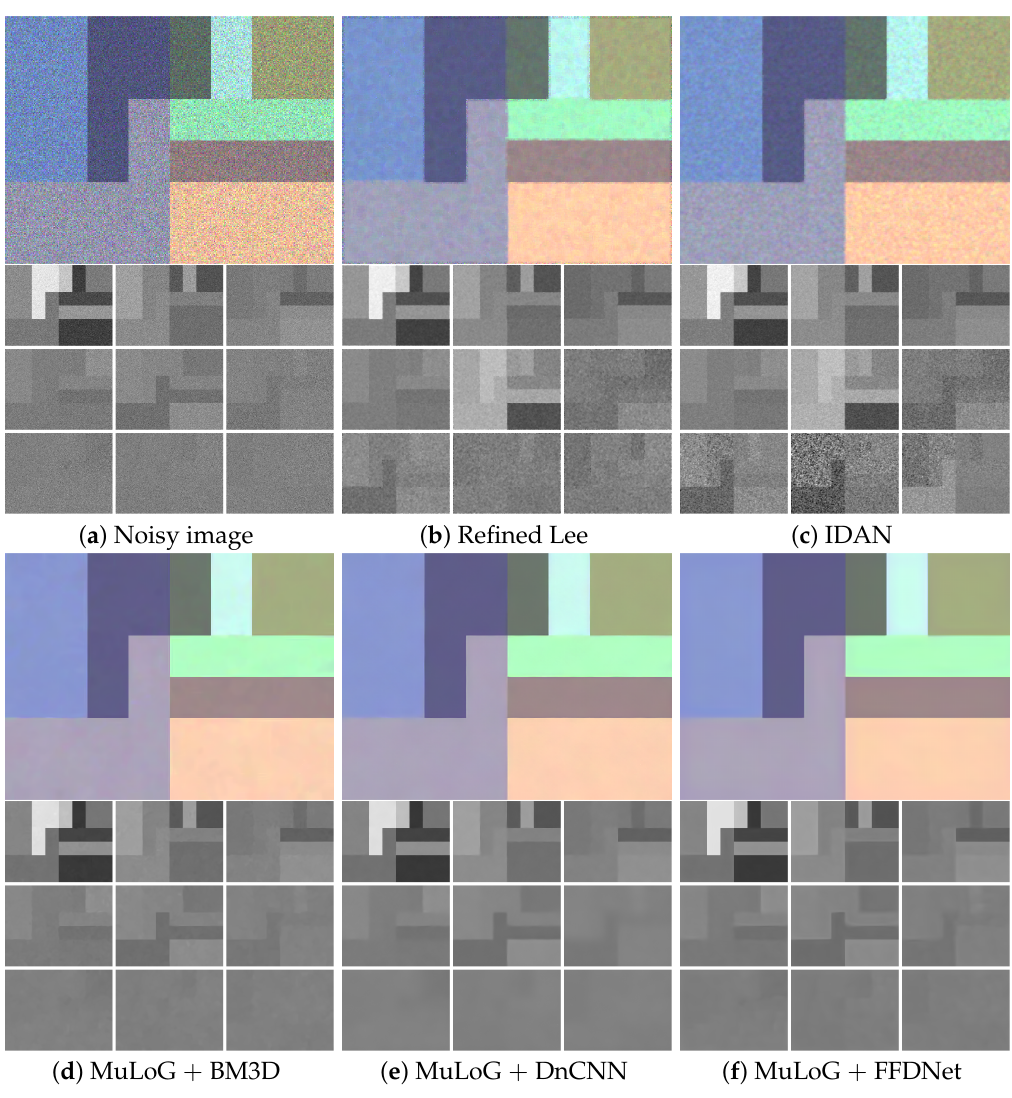
Figure 14. The denoising results for simulated PolSAR image with L = 4: ( a – f ) Noisy image, Refined Lee, IDAN, MuLoG + BM3D, MuLoG + DnCNN, and MuLoG + FFDNet, respectively. For each image, the nine log channels x 1 , x 2 , . . . , x 9 are displayed on below. Table 5. The quantitative comparison of different methods for simulated PolSAR image with L =